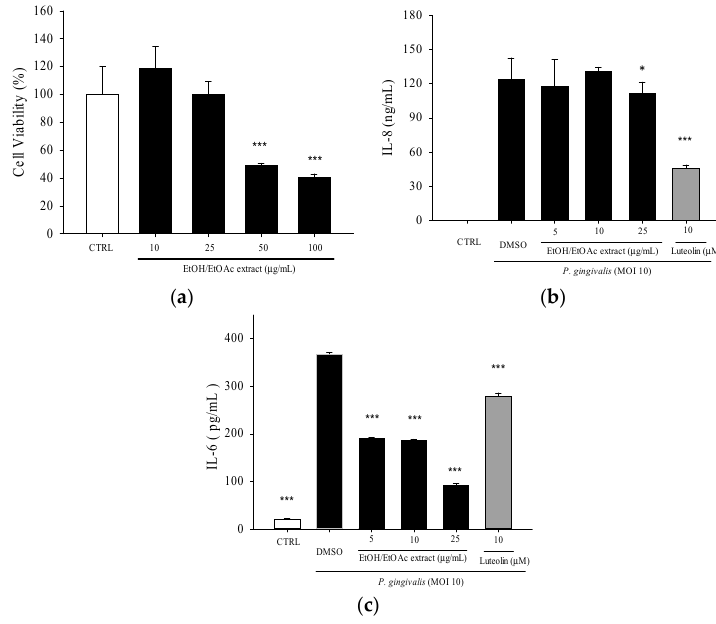
Figure 1. Ethanol/ethyl acetate (EE) extract of WBM leaf inhibited heat-killed P. gingivalis -induced cytokine production by THP-1 cells. ( a ) Cytotoxic effect of EE extract on THP-1 cells was determined by MTT assay. *** p < 0.001 vs. CTRL with 0.1% DMSO alone; ( b ) THP-1 cells were co-incubated with 0.1% DMSO (as vehicle) or the indicated concentrations of EE extract and P. gingivalis (M.O.I. = 10) for 24 h. A control experiment with 0.1% DMSO (CTRL) without P. gingivalis treatment was conducted in parallel. The culture supernatants were subsequently isolated and analyzed for IL-8 and ( c ) IL-6 concentrations. Luteolin was a positive control. Each column shows the mean ± SD of three independent experiments, each done in quadruplicate. * p < 0.05 and *** p < 0.001 vs. DMSO vehicle ( P. gingivalis alone).